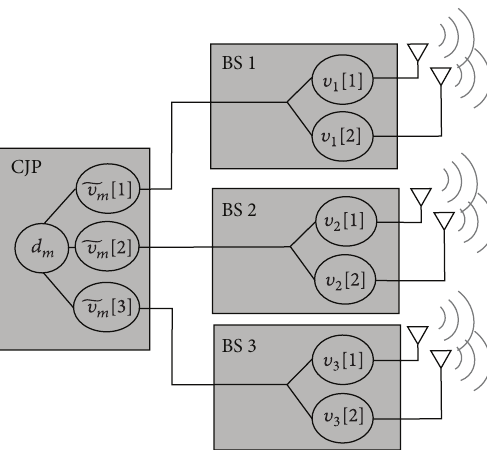
Figure 10: Each element of ̃ v 𝑚 must be spread to all pAEs locally mounted at the BSs. Thus, there is much less cooperation overhead on the backhaul.